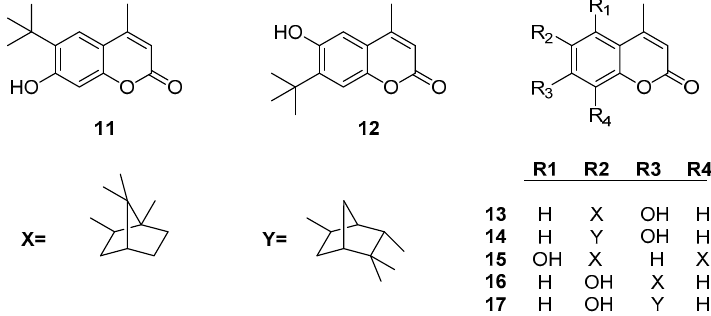
Figure 6. Chemical structures of tert -butylcoumarins 11 and 12 and terpenylcoumarins 13–17